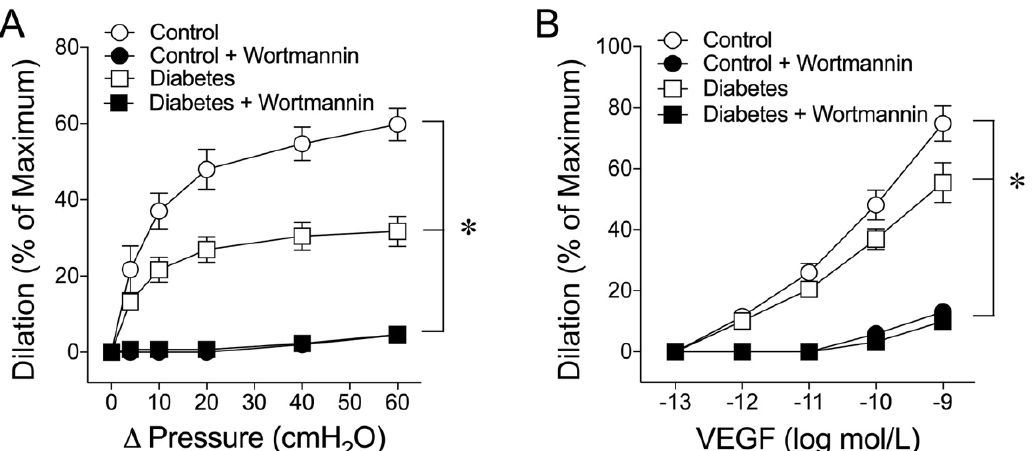
Figure 5. Effect of PI3K inhibition on flow- and VEGF-induced coronary arteriolar dilations. ( A ) The dilation of coronary arterioles to increased luminal flow (Control; n = 4) was attenuated by diabetes (n = 4) and administration of PI3K inhibitor wortmannin (0.1 µmol/L) abolished dilation of the con- trol (n = 5) and diabetic (n = 5) vessels. ( B ) The VEGF-induced vasodilation (Control; n = 5) was abolished by wortmannin (n = 5) and the dilation of the diabetic vessels (n = 5) was also abolished by wortmannin (n = 5). The resting vascular tones were not altered before and after wortmannin in either control (64 ± 2% vs. 64 ± 2%) or diabetic (62 ± 3% vs. 65 ± 2%) vessels. * p < 0.05 vs. diabetes .